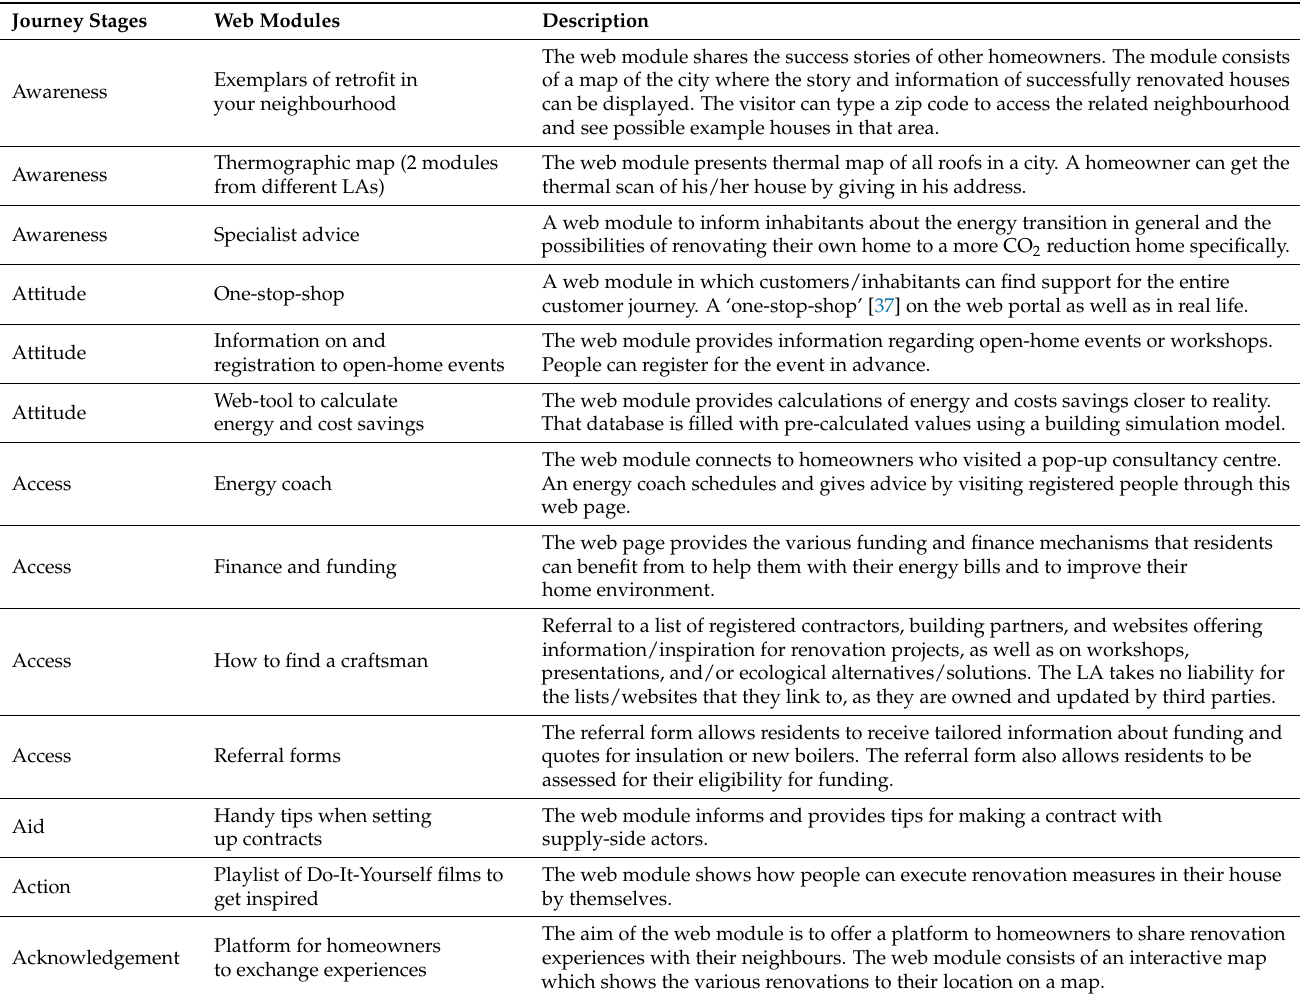
Table 2. Web modules implemented by seven local